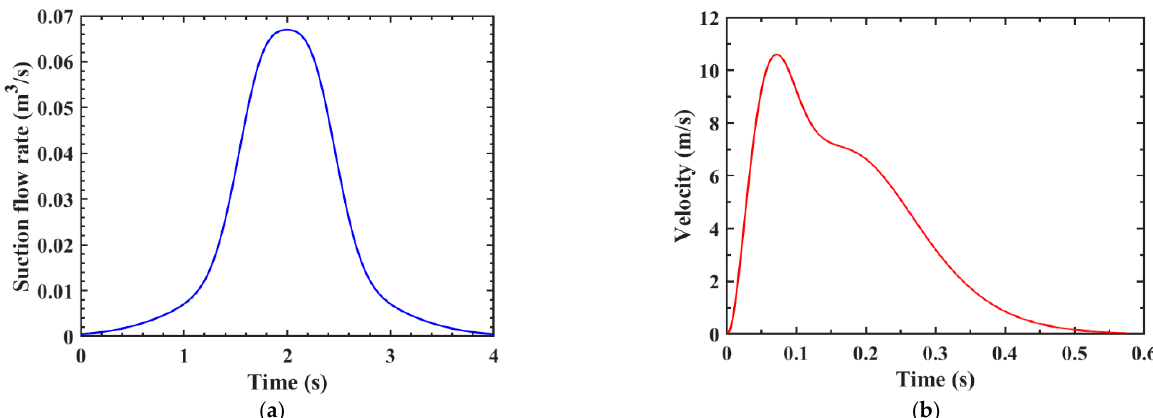
Figure 4. ( a ) Temporal suction flow rate profile at the opening of the vacuum toilet trap; ( b ) temporal velocity profile at the mouth of the manikin during coughing.